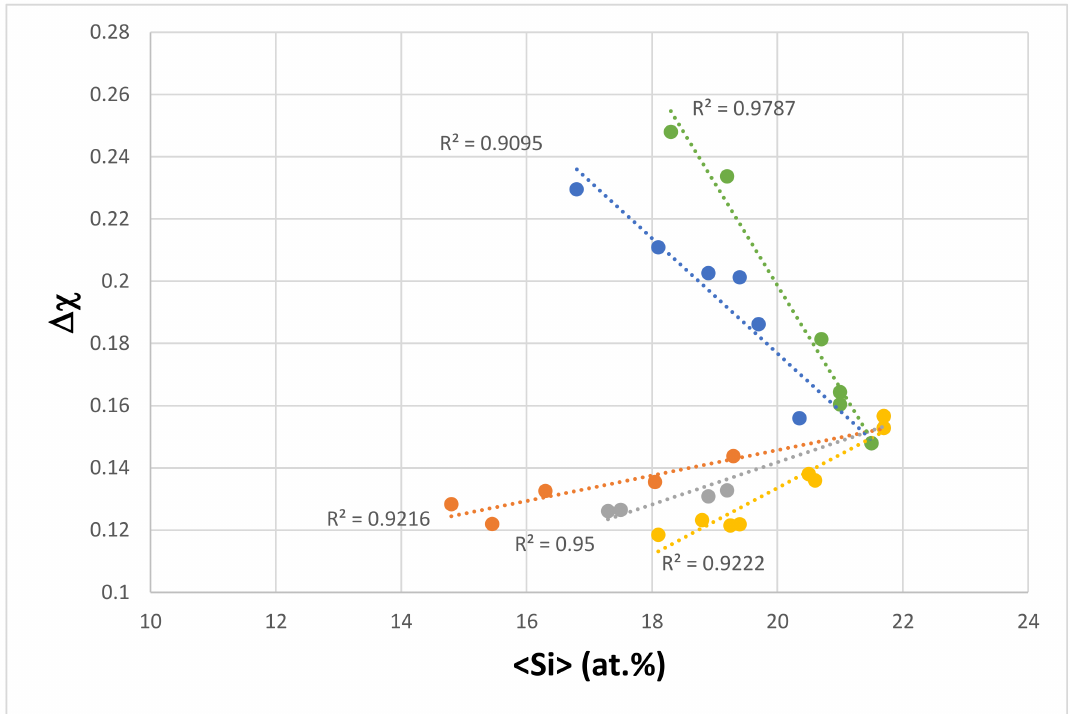
Figure 6. ∆ χ versus <Si> of eutectics with Nb ss and Nb 5 Si 3 in Nb-silicide based alloys. Series a (R 2 = 0.9216) with alloying element additions of Al, Cr, Fe, Ge, Hf, Si, Sn, Ti, and Y; series b (R 2 = 0.9222) with alloying element additions of Al, Cr, Ge, Hf, Si, Sn, and Ti; series c (R 2 = 09095) with alloying element additions of Al, Cr, Fe, Ge, Hf, Mo, Si, Sn, Ta, Ti, V, W, and Zr; series d (R 2 = 0.9787) with alloying element additions of Al, Cr, Fe, Ge, Hf, Mo, Si, Sn, Ta, Ti, and W; series e (R 2 = 0.95) with alloying element additions of Al, Cr, Ge, Hf, Si, Sn, Ti, and